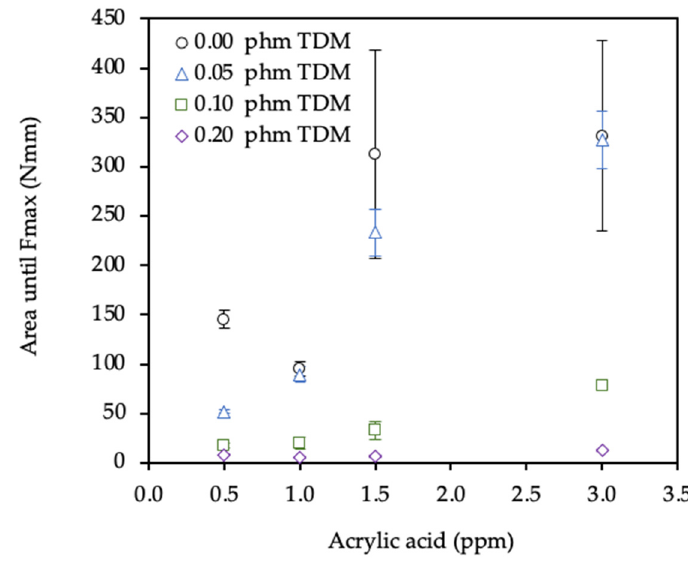
Figure 11. E ff ect of acrylic acid and tert-dodecyl mercaptan (TDM) on the deformation energy until failure of the adhesive.